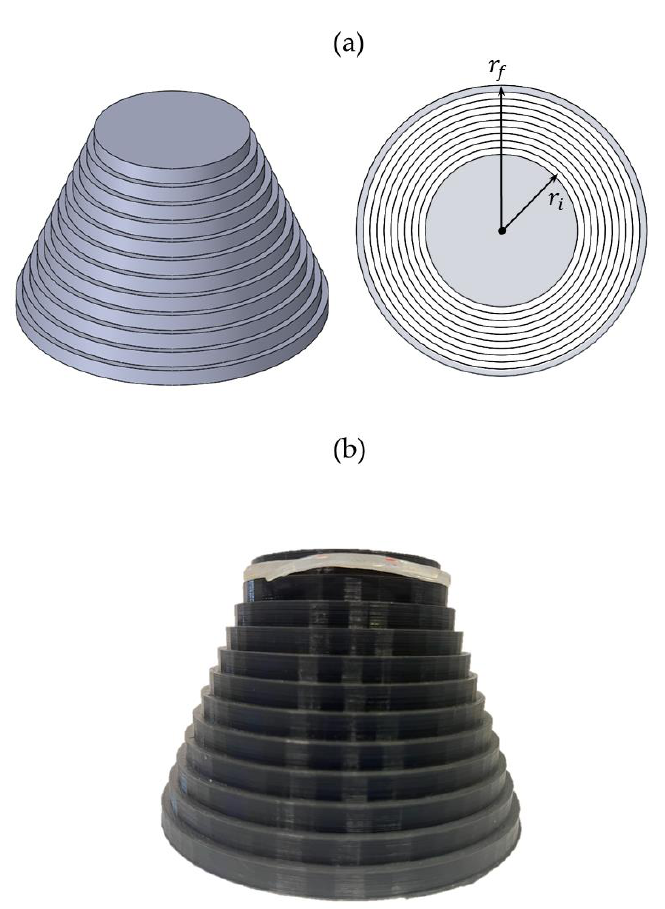
Figure 5. Design of the ring tower ( a ), the printed structure with the ring-shaped sensor placed around the first ring ( b ).